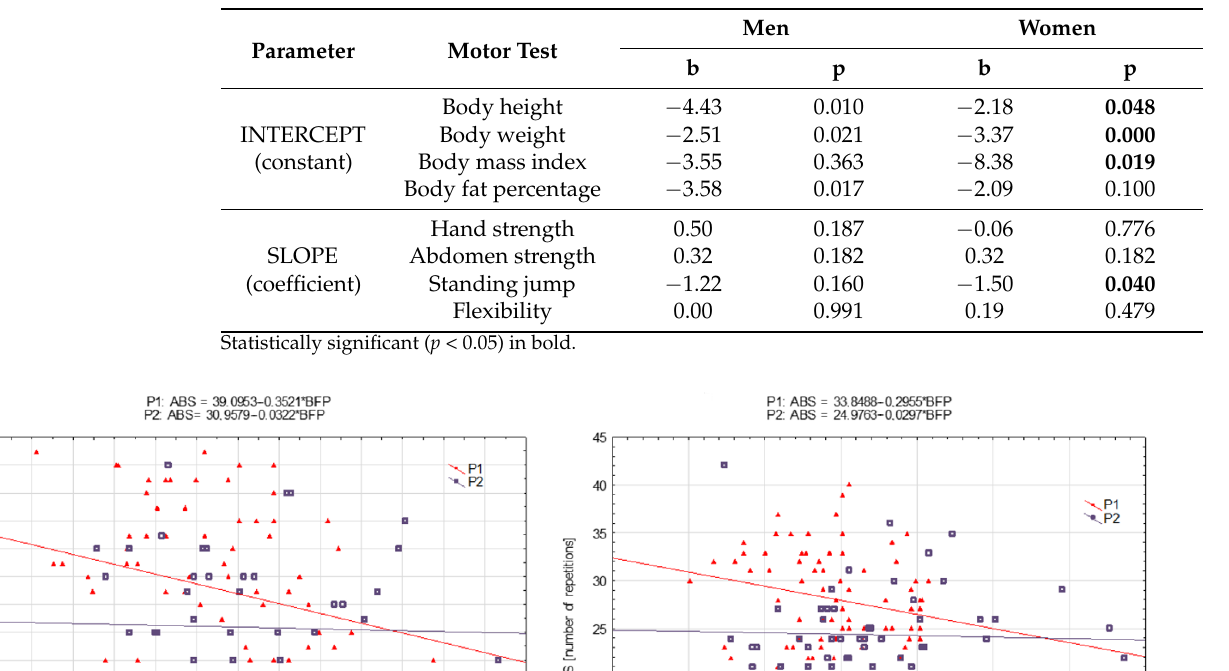
Figure 1. Hand strength (HS) measured in 2001 (P 1 ) and 2022 (P 2 ) regressed on body fat percentage (BFP)—men and women, respectively. Table 5. Statistics (b-coefficients and corresponding p -values) derived from multivariate regression analysis to test statistical significance of the differences between intercepts and slopes calculated in simple regressions for relationships between motor tests and BFP in men and women examined in P 1 and P 2 .